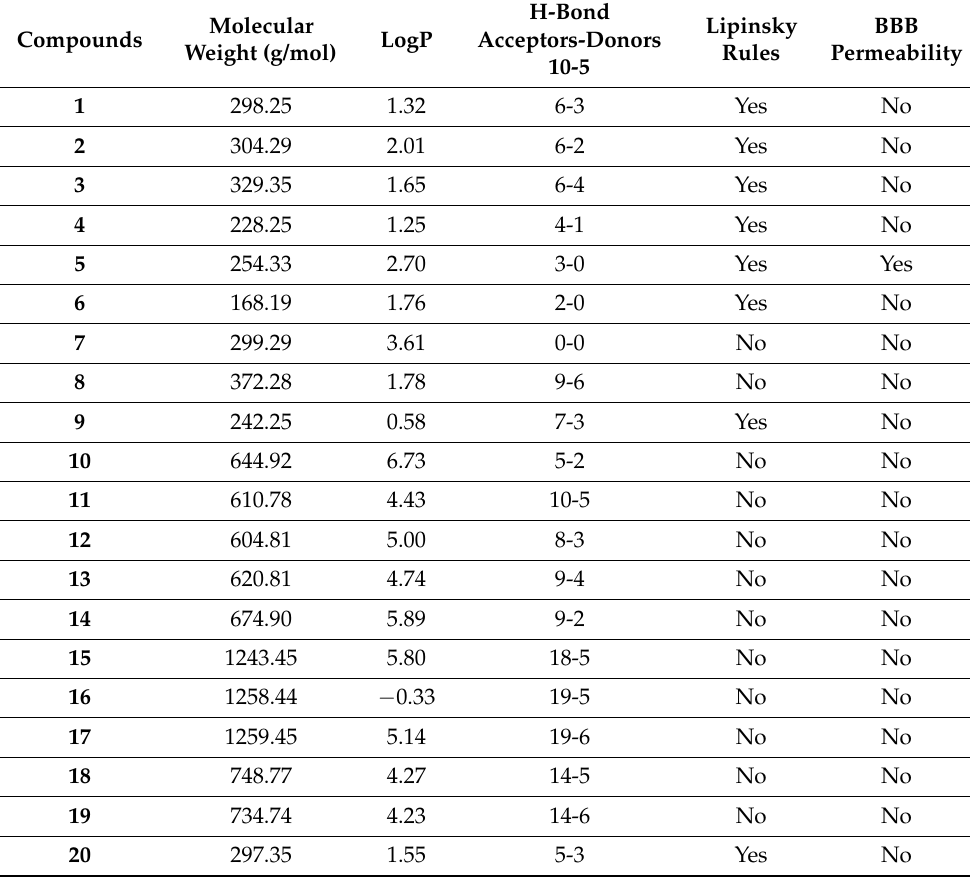
Table 1. Pharmacokinetic parameters of marine compounds that are described in this review.